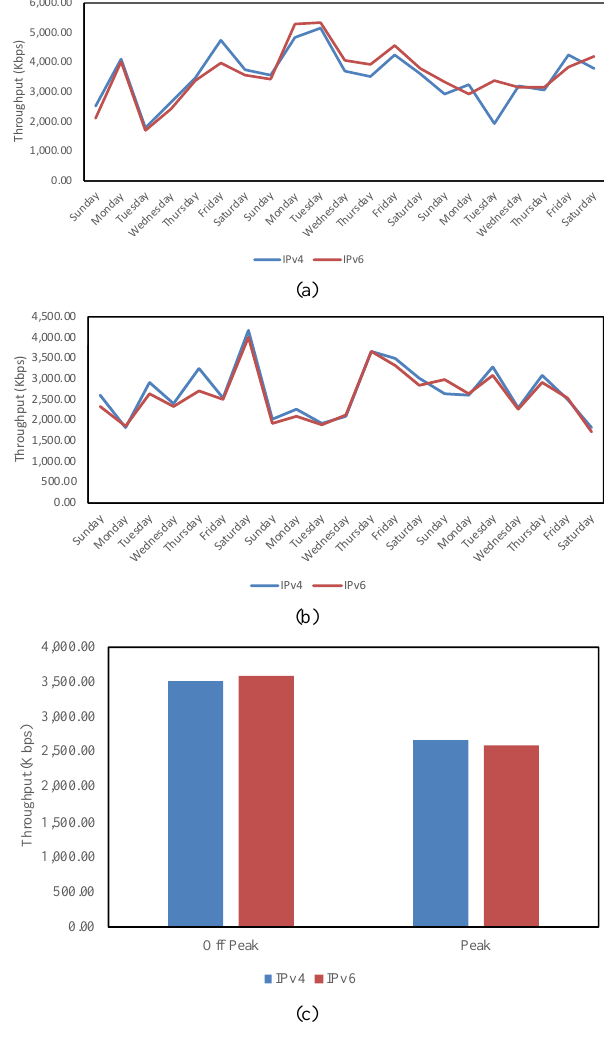
Fig. 17. Throughput test result: (a) off-peak hour; (b) peak hour; (c) average The daily monitoring of total IPv4 session from one month before cut-off date up to nine months after shows 69.64% saving against the